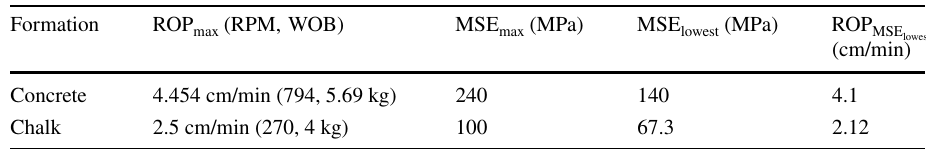
Table 4 Highest measured ROP with corresponding MSE, RPM and WOB. Lowest measured MSE with corresponding